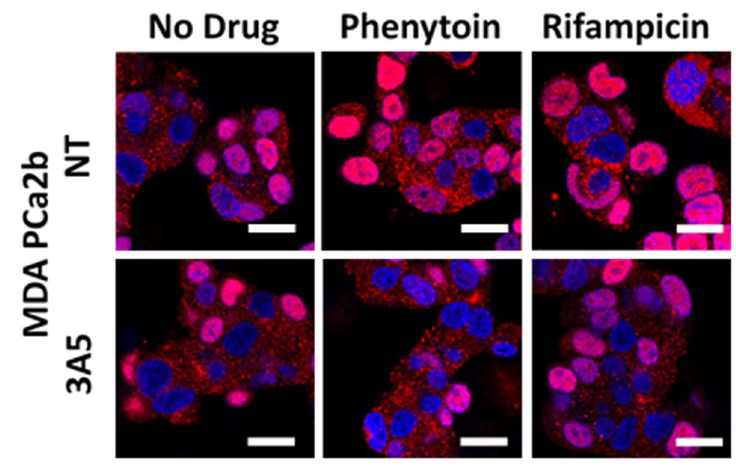
Figure 4. Modulation of AR signaling is dependent on CYP3A5 modulation. AR nuclear translocation by CYP3A inducers in NT/CYP3A5 siRNA treated MDAPCa2b cells. MDAPCa2b cells were treated with NT/CYP3A5 siRNA pool for 24 hours and then incubated with CYP3A inducers, phenytoin (75 µM), and rifampicin (30 µg/mL) for 48 hours in complete media. Confocal microscopy was performed and center of Z-stack is shown for nuclear AR localization. AR-red (Cy5) and nucleus (blue-DAPI). Scale bar represents 25 µ m.